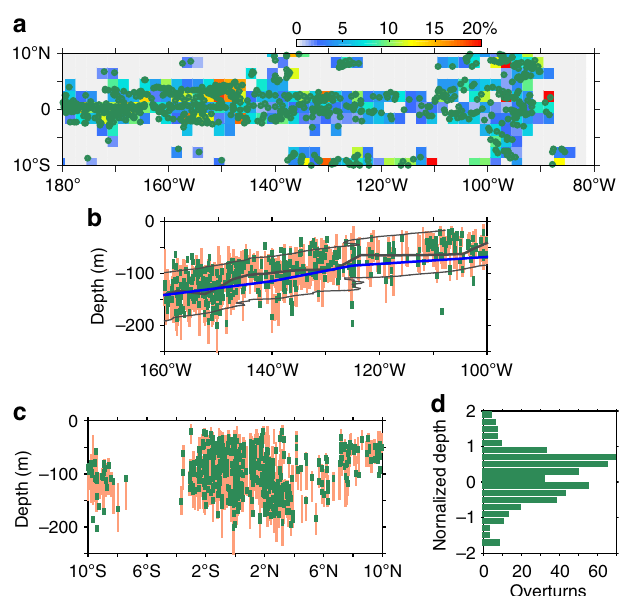
Figure 1 | Spatial distribution of detected density overturns in the equatorial Pacific cold tongue. ( a ) Occurrence probability (colour) and horizontal locations of overturns (dark green dots). ( b ) Depth and sizes (in metres) of the overturns (dark green bars) occurred between 3 (cid:2) S and 6 (cid:2) N, and the corresponding PLs (light orange bars) from a latitudinal view. The blue curve denotes the mean depth of the EUC core (averaged over ± 1 (cid:2) ; data are obtained over the 1990s (ref. 70)). The thick black curve and thin black curves denote the centre (depth of maximum N 2 ; N 2 ) and max ) of the mean pycnocline. N 2 is calculated from bounds (depths of half N 2 max sample mean density that is meridionally averaged from all fine-resolution Argo profiles over ± 1 (cid:2) . ( c ) The same as in b but assembled from data between 160 and 100 (cid:2) W (curves of average variables are not added due to large zonal variation). ( d ) Histogram of overturns at the referenced and normalized vertical coordinate.